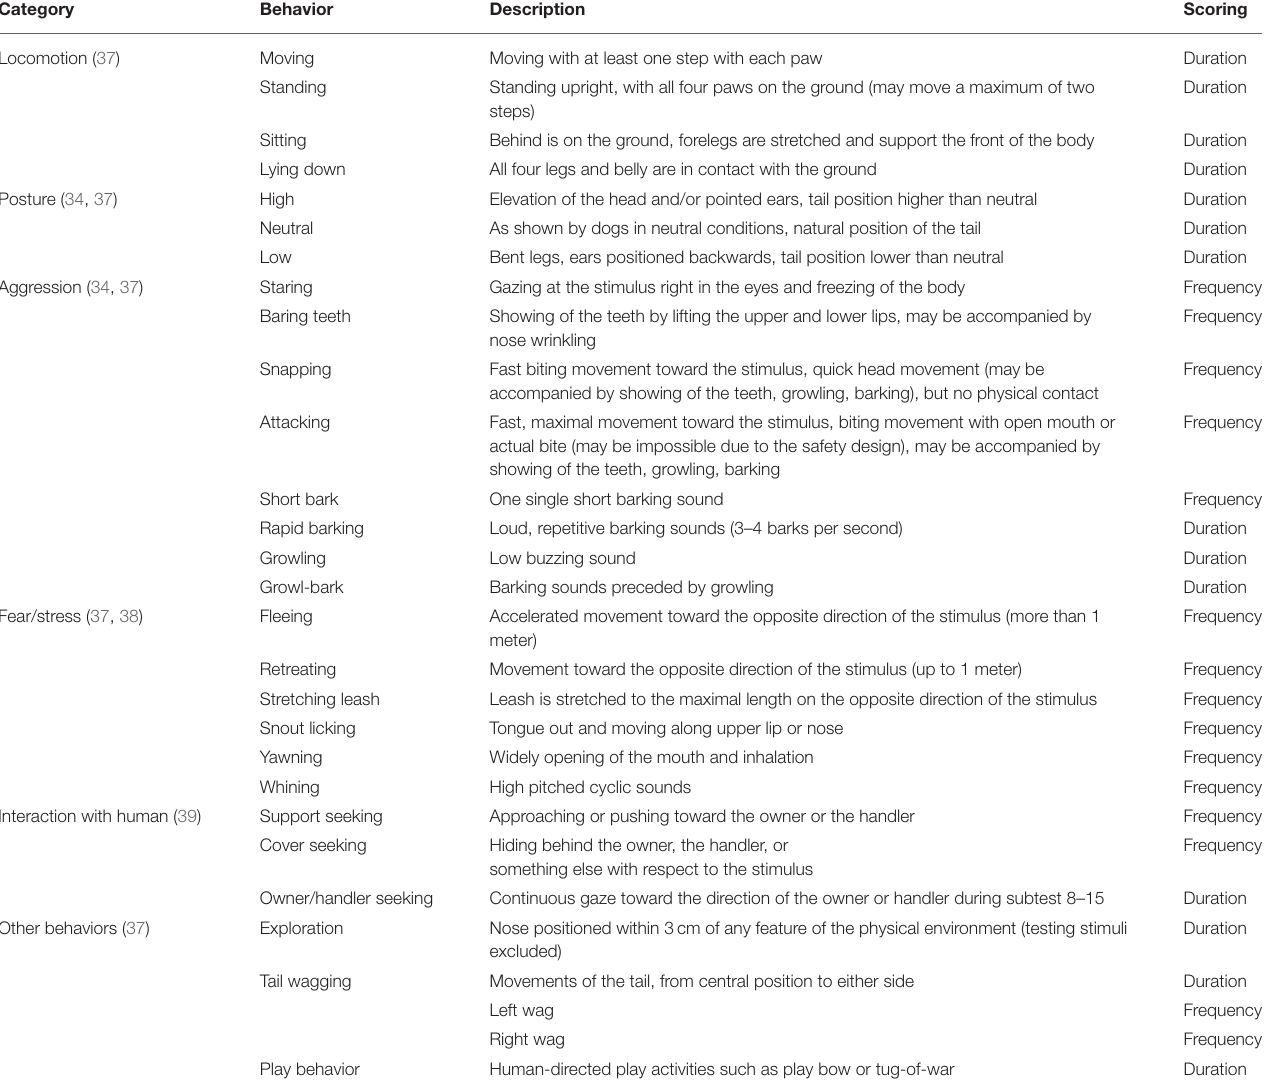
TABLE 1 | Descriptive ethogram of the observed behaviors during SAB